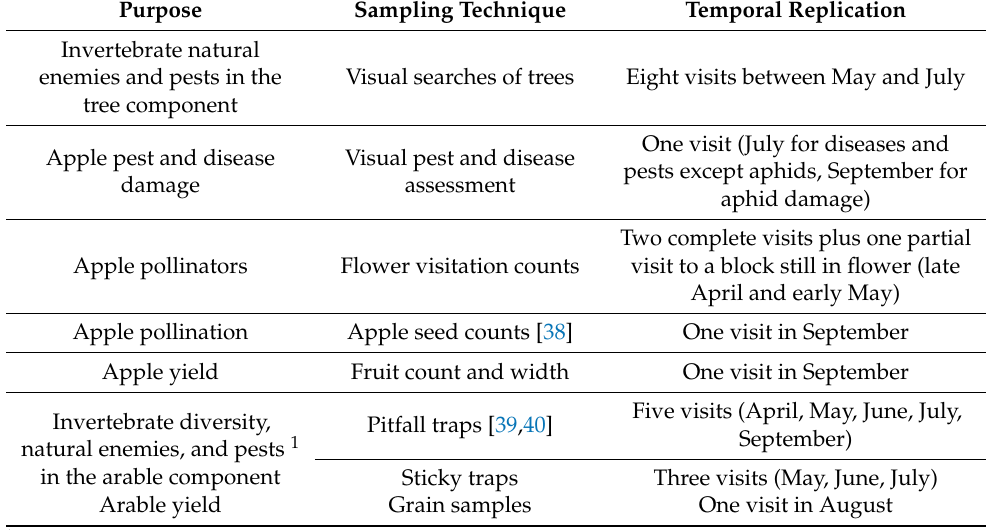
Table 1. Summary of sampling techniques used in the study. For further information on sampling methodology, see Table S2.